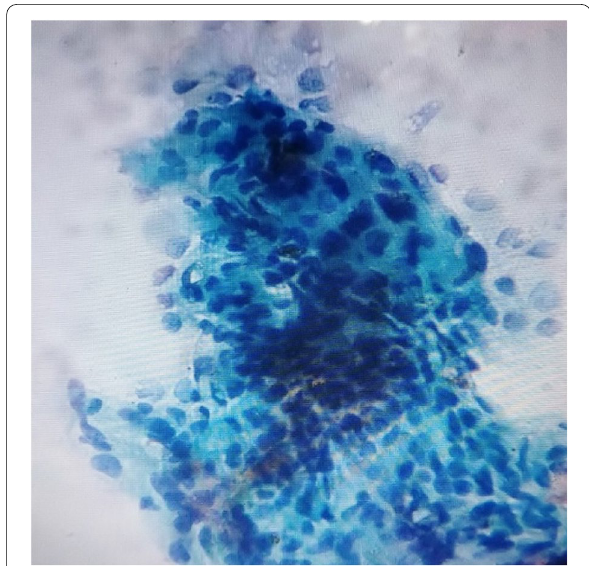
Fig. 3 Metastatic renal cell carcinoma on MGG stained-squash smear cytology; 100